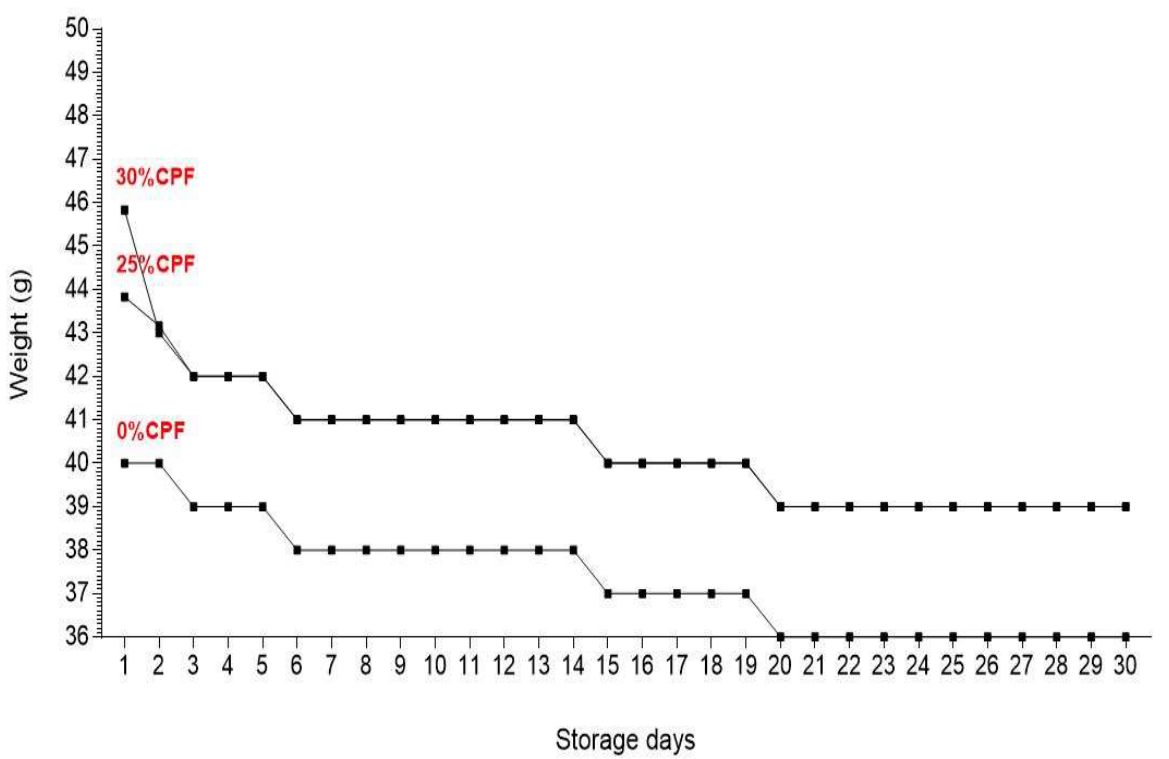
Figure 4. Weight variation of durum wheat tortilla and fortified durum wheat tortillas during stor- age.